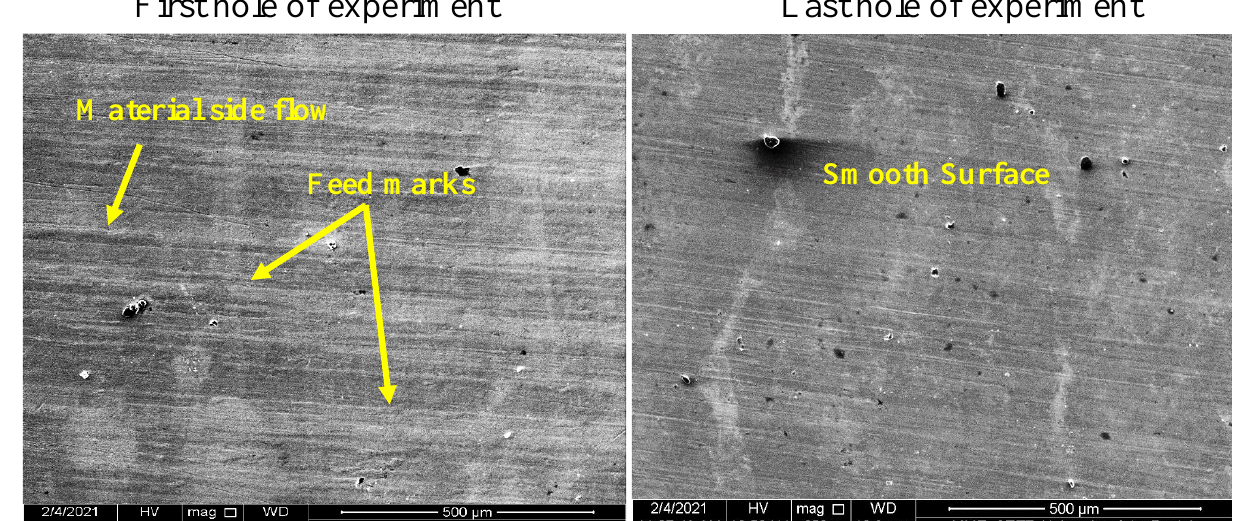
Figure 20. Surface topography of cross-sectional SEM images of drilled holes of Tests 4 (35 m/min, 0.04 mm/rev).